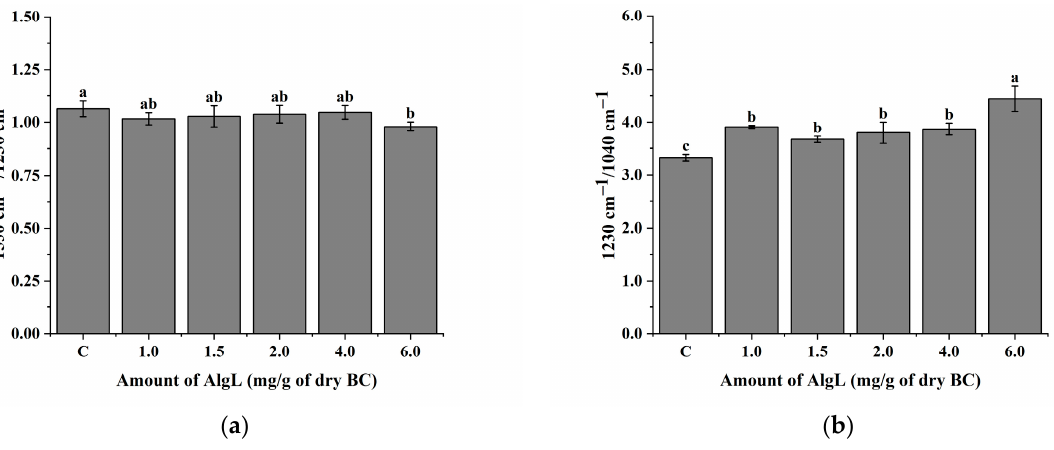
Figure 11. The relative changes in the band ratio, 1530 cm − 1 /1230 cm − 1 ( a ) and 1230 cm − 1 /1040 cm − 1 ( b ). The means with the same superscript (a, b) are not significantly different, with p > 0.05. Error bars represent standard deviation.